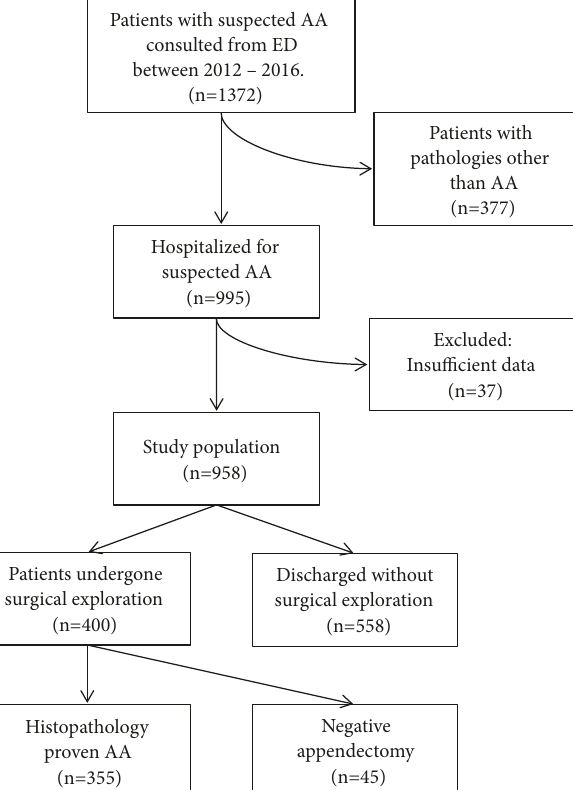
Figure 1: Flowchart of patients included in the study (AA: acute appendicitis, ED: Emergency